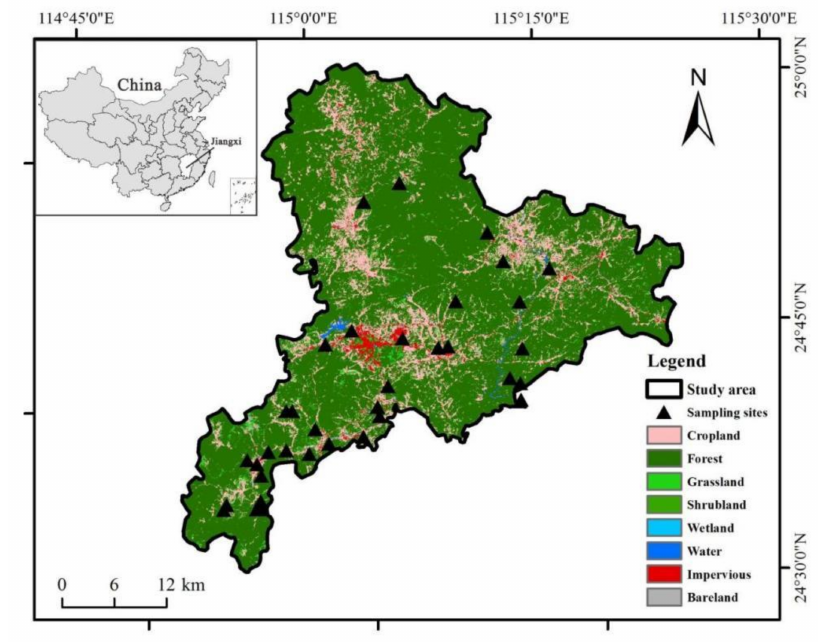
Figure 1. Location of study area and sampling